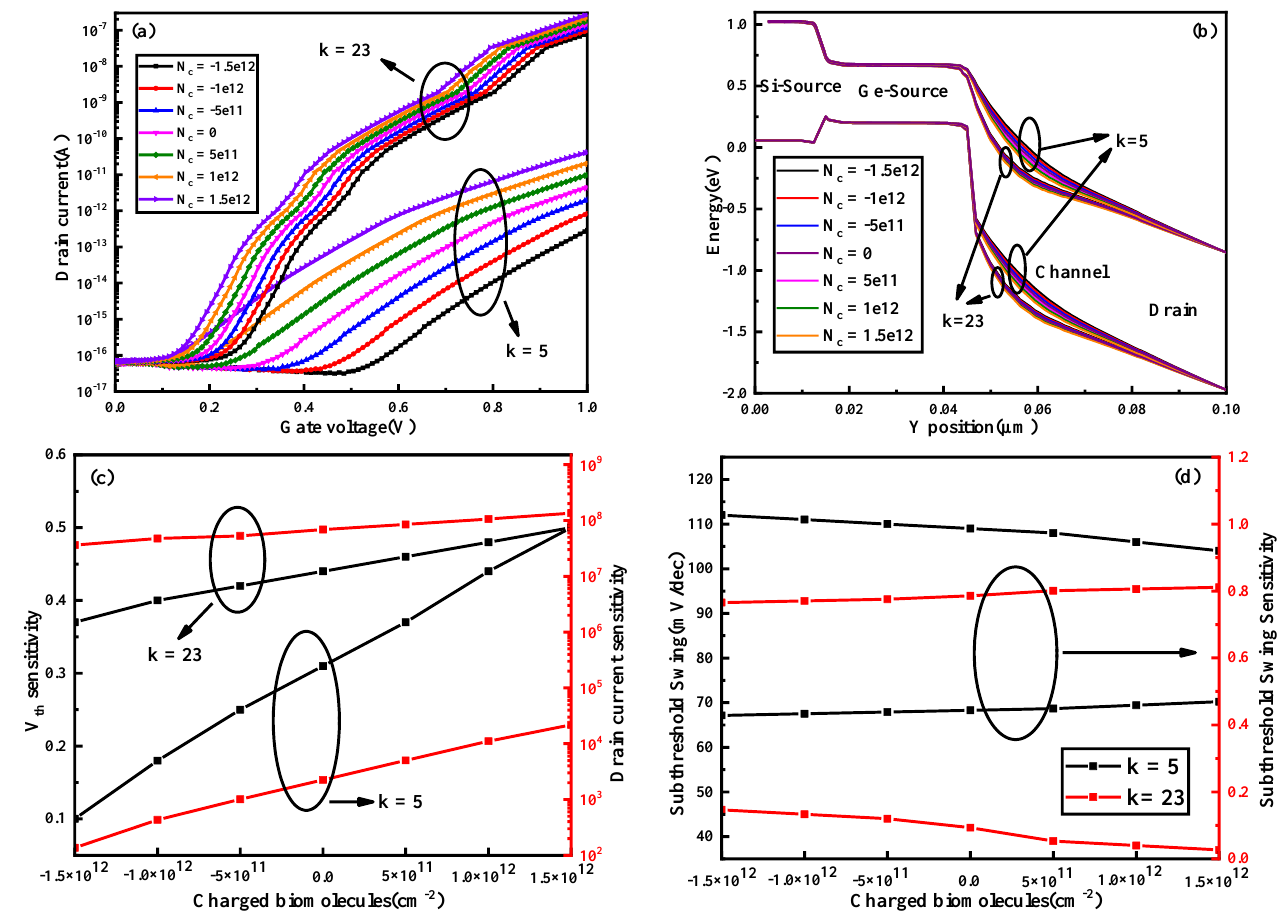
Figure 7. ( a ) Transfer characteristics, ( b ) energy band variation with respect to the y − axis and ( c ) S Vth and S d and ( d ) SS and S SS of the DM − SSTGTFET biosensor for different charged biomolecules at V d = 0.5 V, V g = 1 V and t c = 5 nm.